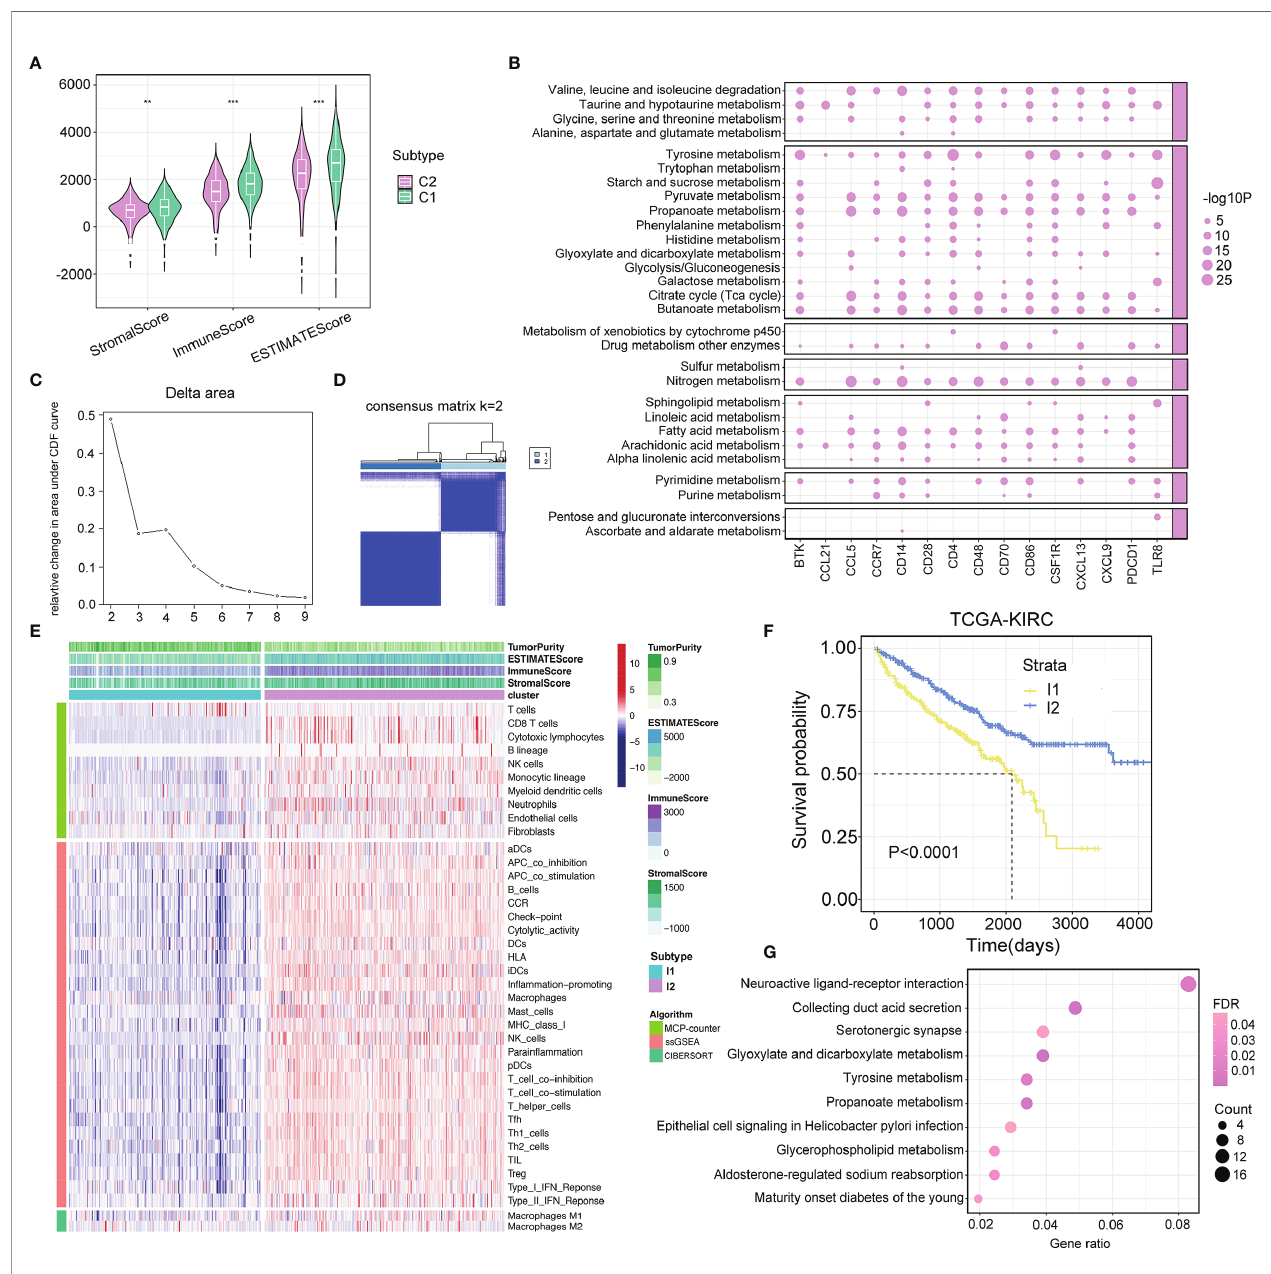
FIGURE 3 | Crosstalk between metabolism and immune regulations. (A) Comparison of immune score, stromal score, and estimate score between two metabolism subtypes. p-value is given by Wilcoxon rank-sum test. **p < 0.01, ***p < 0.001. (B) The interplay between upregulated immune-related molecules and metabolism pathways. The point represents that the upregulated immune-related molecules are signi fi cantly enriched in the relevant metabolism pathways. The size of the point represents the value of − log10 (FDR). (C, D) The cumulative distribution function curves of consensus matrix indicate that when k=2, the interference between subgroups is minimal. (E) Heatmap describes the abundance of immune components in fi ltration calculated by ssGSEA, MCP-counter, and CIBERSORT algorithms in two immune subtypes (I1 and I2). (F) Survival analysis in I1 and I2 subtypes. p -value is given by log rank test. (G) Pathway analysis of differentially expressed genes between two immune